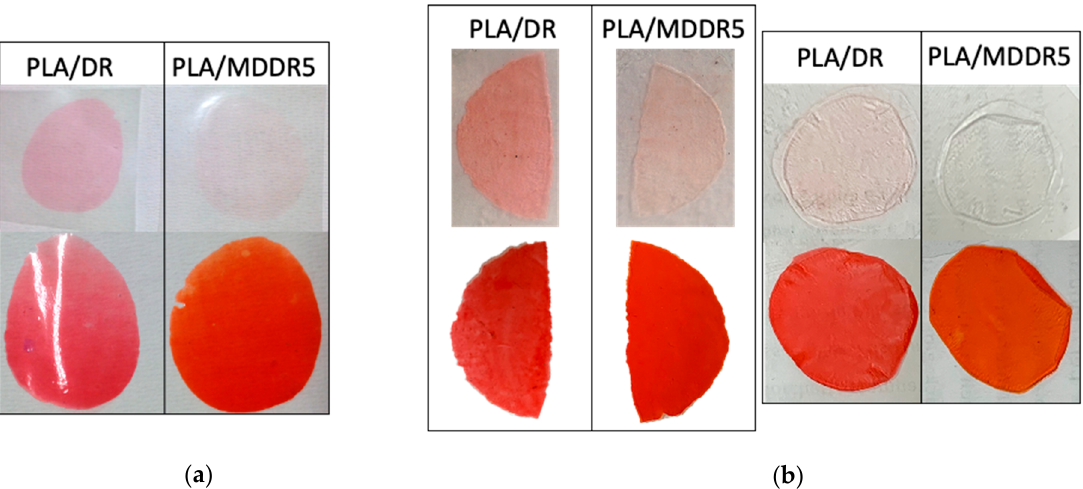
Figure 10. ( a ) Pictures of color transfer from PLA / DR or PLA / MDDR5 to poly(ethylene-terephthalate) (PET) at 130 ◦ C. Upper part of the picture: PET films where the spots of DR (left) and MDDR (right) are present. Lower part of the picture: PLA / DR (left) and PLA / MDDR5 (right) film after the contact with PET. ( b ) Pictures of color transfer from PLA / DR or PLA / MDDR5 to styrene butadiene copolymer (SBC) at 120 ◦ C on the right and at 100 ◦ C on the left. Upper part of the pictures: styrene butadiene copolymer (SBC) films where the spots of DR and MDDR are present. Lower part of the pictures: PLA / DR and PLA / MDDR5 film after contact with SBC (see the text and Section 2.5 for details.).